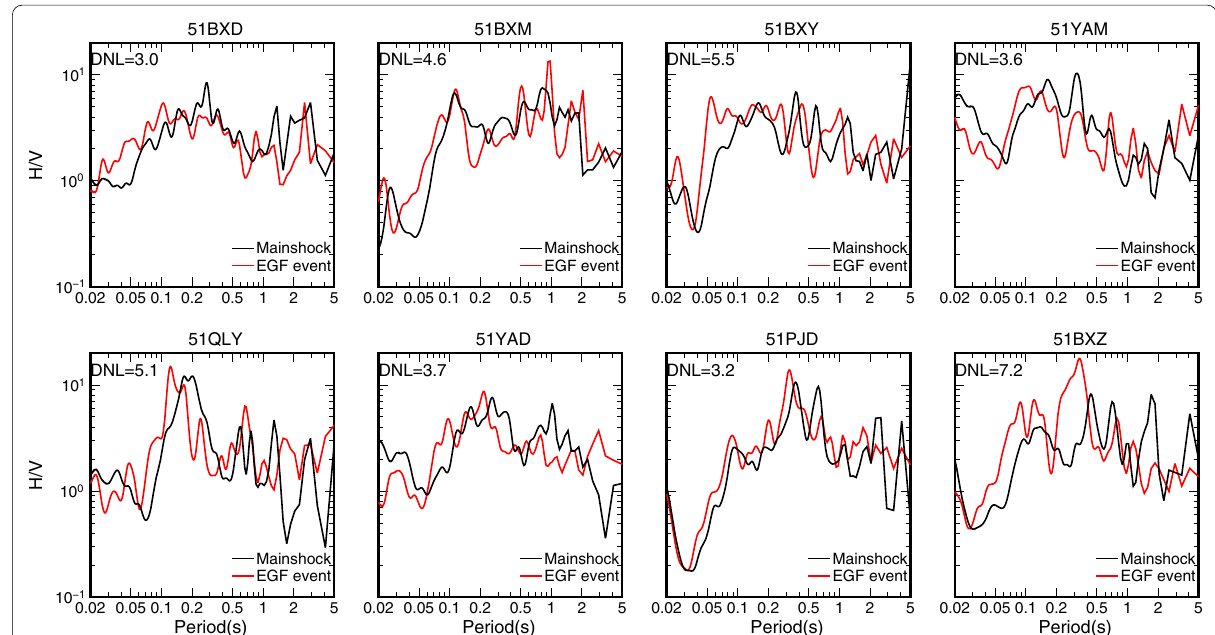
Fig. 7 Comparison of the earthquake H/V spectral ratios between the mainshock (black) and the EGF event (red). The degree of nonlinearity (DNL) is shown in the left-top of each panel